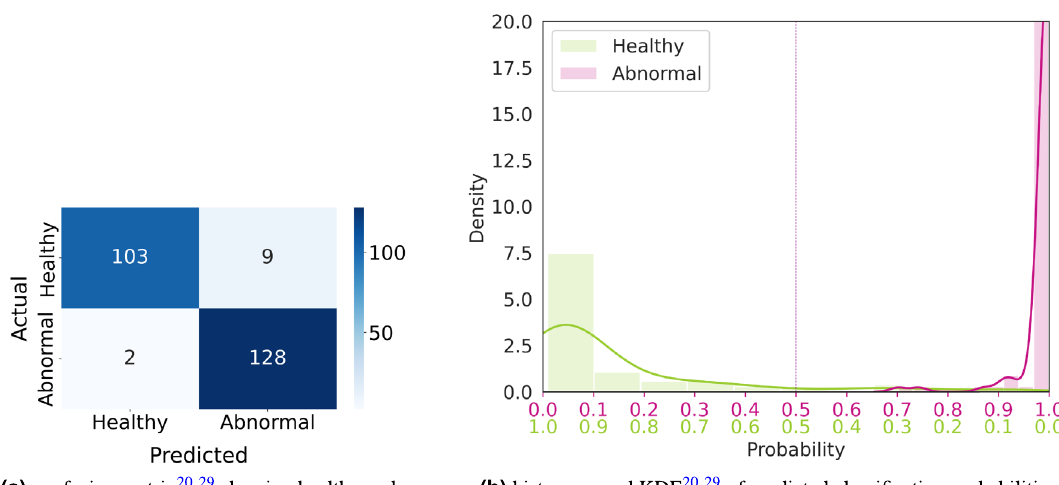
Figure 2. The performance of the CorNeXt model on the test cornea scans dataset in distinguishing between healthy and abnormal cornea scans. ( a ) The confusion matrix of the model. ( b ) How confident the model is when classifying a cornea scan as healthy or abnormal . The threshold for probabilistic model output was set to 0.5 (marked by the vertical line).